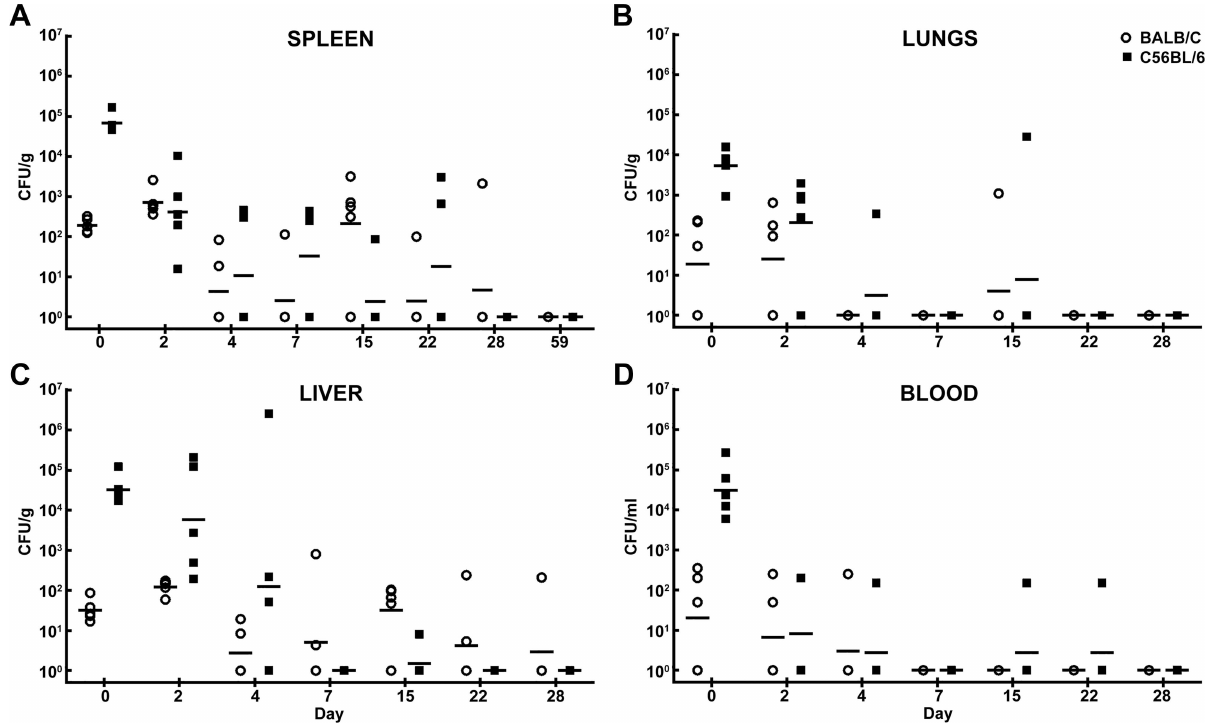
Fig 2. Bacterial burden determined in mice challenged with B . pseudomallei K96243delivered via the IP route. CFU/g for spleen (A) , lungs (B) , liver (C) and CFU/ml for blood (D) are depicted.The geometric mean for each group is indicatedby a horizontalbar. BALB/C mice are depicted with open circles and C57BL/6mice are depictedwith filled squares. N = 5 at each time point.